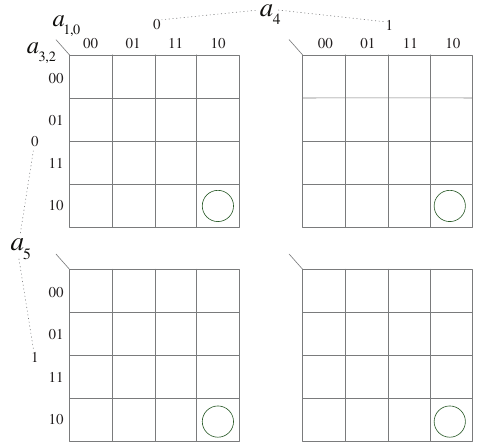
FIG. 18. A Karnaugh map on six input variables. One should regard the submaps as separate pieces of paper stacked up in the order a 5,4 = 00, 01, 11, 10, in clockwise order. The top and bottom sheets are adjacent because of periodicity. A cell is con- sidered adjacent to the cell in the sheet above or below it in addition to adjacencies in the four-variable map. As an exam- ple, a two-variable subcube with four cells can be formed from the collection of the lower-right cells of all four submaps, with inputs a 3,2,1,0 = 1010 or a 3 ¯ a 2 a 1 ¯ a 0